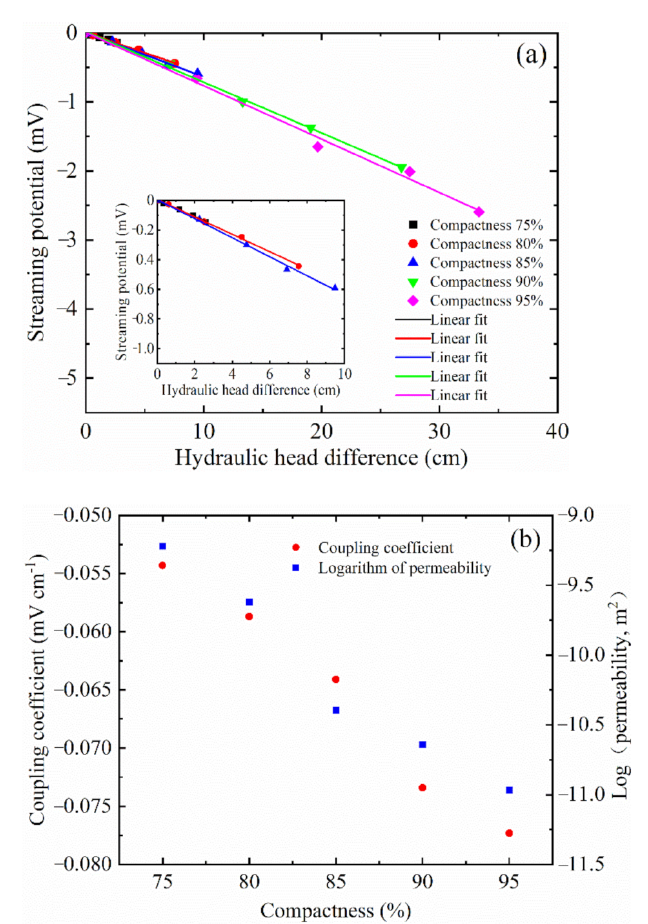
Figure 6. Experimental results of compactness. ( a ) Streaming potential ∆ U (mV) against hydraulic head difference H (cm) for different compactness samples saturated with 0.01 M NaCl solution. The streaming potential coupling coefficient is determined as the slope of the linear regression. The inset focusing on the 75%, 80%, and 85% compactness domain. ( b ) The relationship between the coupling coefficient and permeability of SRM at different compactness.